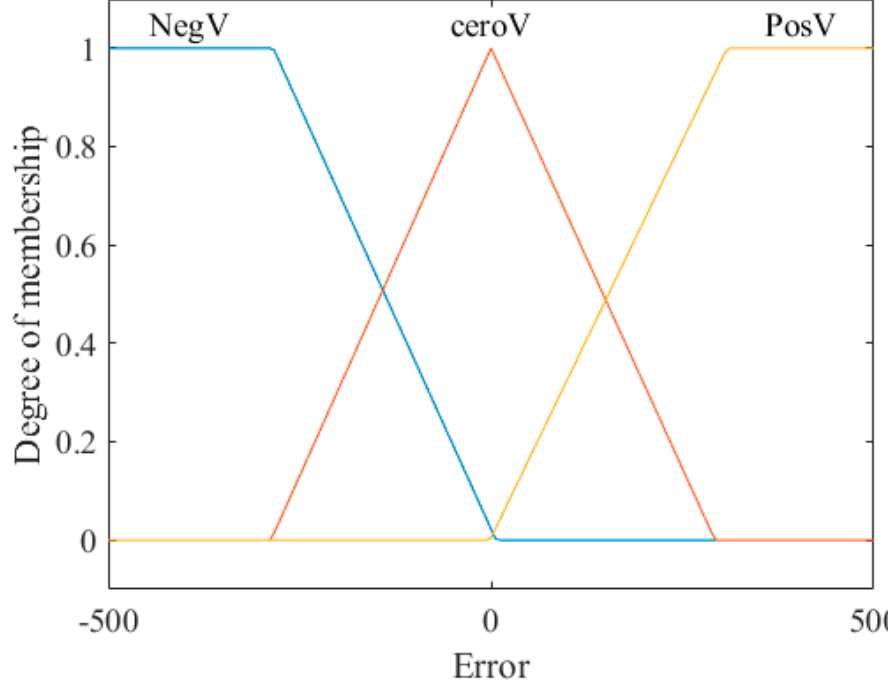
Figure 8. Input 1 for the FLC with step speed reference.